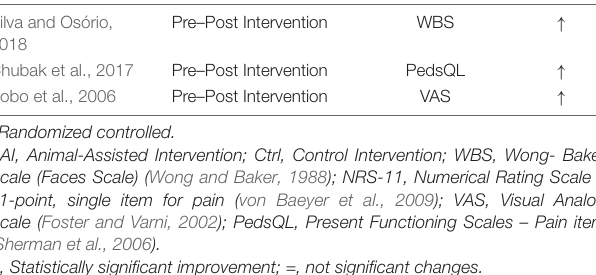
TABLE 4B | Effect of AAI on pain (uncontrolled studies).